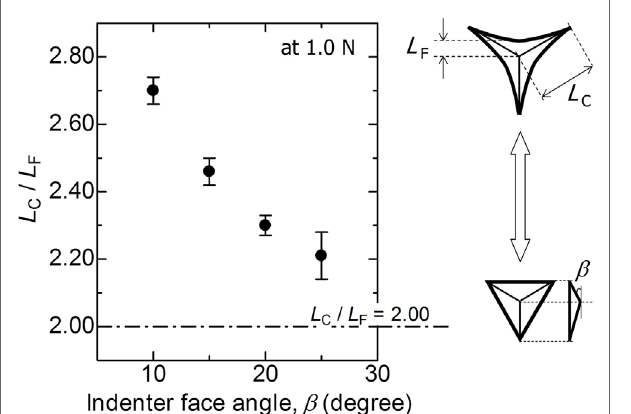
FigUre 3 | relation between the bowed-in parameter, L c / L f and the face angle of indenter . The indentation load is 1.0 N. Error bars denote ± 1 SD. The inserted figures represent schematic illustrations of the contact regions (concave and regular triangles).